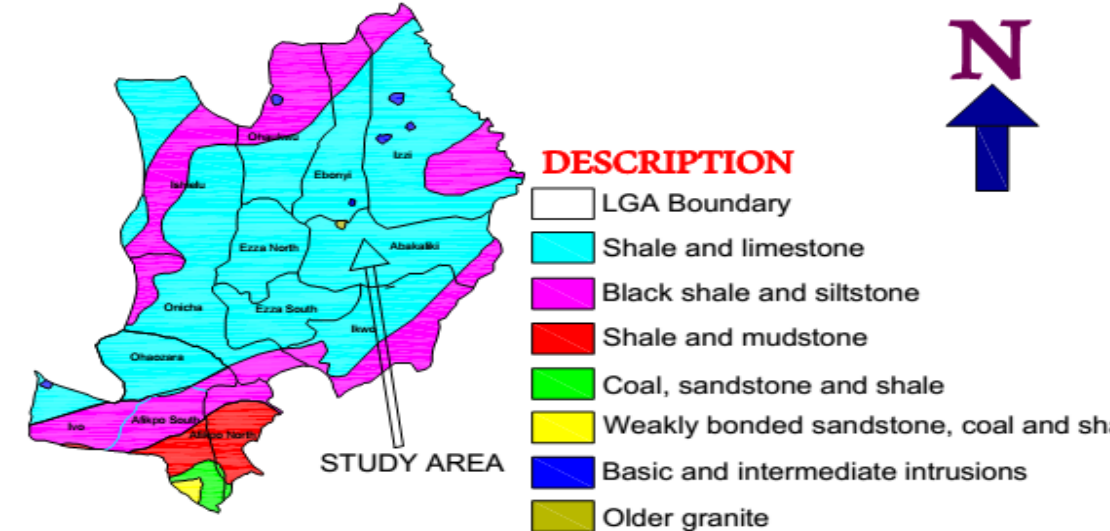
Fig. 1. Geological map of Ebonyi State is showing the soil